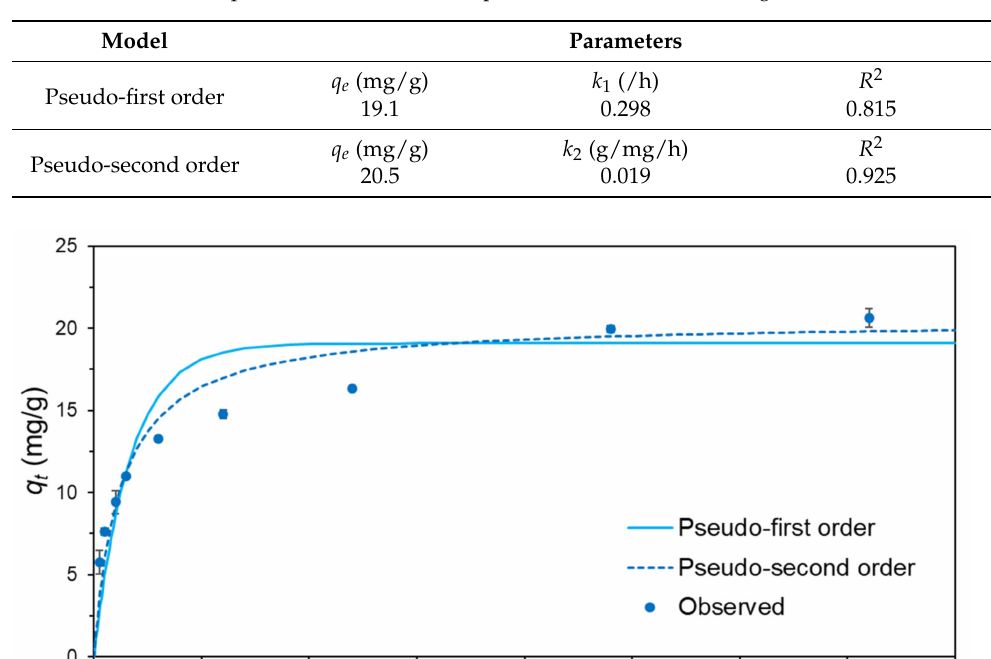
Table 4. Kinetic model parameters of As(III) adsorption onto Al-FWB at a 100 mg/L initial concentration.